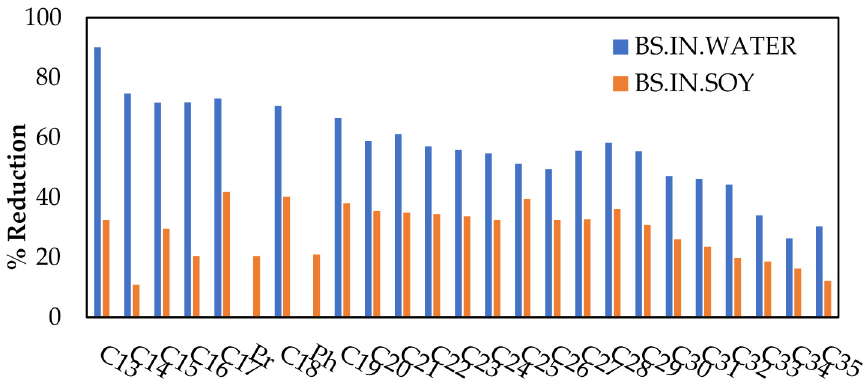
Figure 6. Bioremediation test results. Saturated hydrocarbons concentration after 28 days of bioremediation (Cx are the saturated hydrocarbons, x is the number of carbons in the molecule, Pr: pristane and Ph: phytane). (a) SW_CO: Sea water with crude oil. (b) SW_CO_SOY: Sea water, crude oil and soybean oil (c). SW_CO_NP: Sea water, crude oil and N and P nutrients. (d) SW_CO_NP_SOY: Sea water, crude oil, N and P nutrients and soybean oil. (e) SW_CO_NP_15% BS.IN.SOY: Sea water, crude oil, N and P nutrients and BS-in-SOY agent 15% w/v.